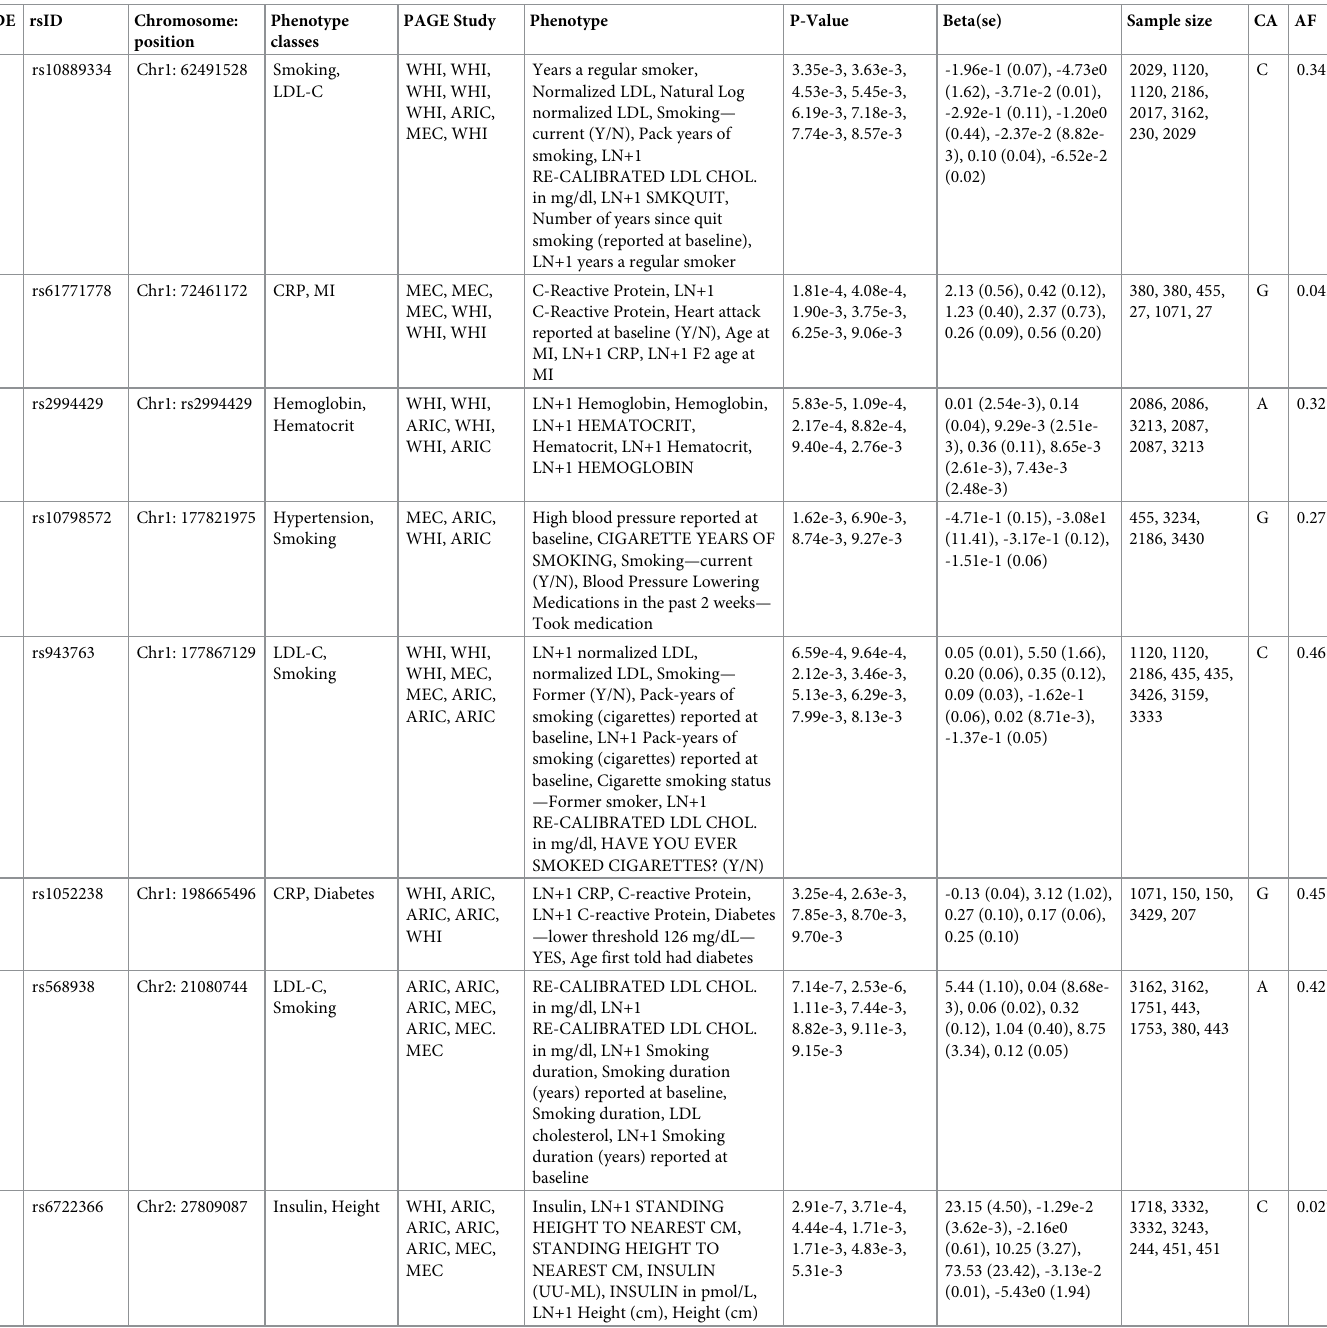
Table 4. Concomitant PheWAS results in African Americans from the Population Architecture using Genomics and Epidemiology (PAGE) study. Test of associa- tion results (p-values, betas, standard errors) are shown for variants associated at p-value < 0.01 (empirically defined) with two or more phenotype classes. An asterisk in the direction of effect column indicates an opposite direction of effect for two of the phenotype classes listed. Genomic position given is based on hg38. Allele frequency is based on all African Americans across PAGE studies regardless of